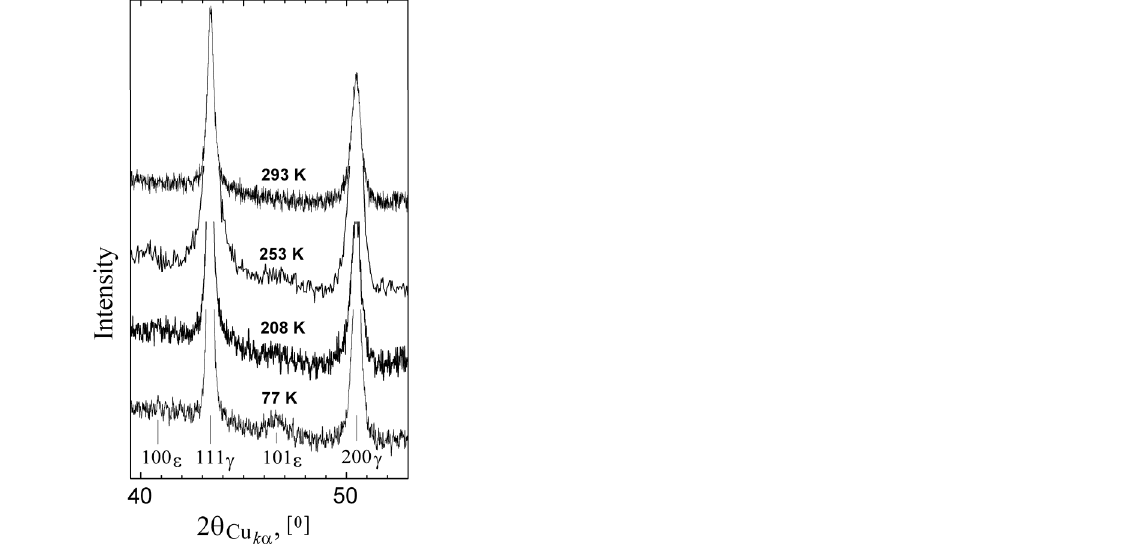
Figure 4. Fragments of the XRD diffraction patterns of the Cr-Mn-N steel after the tensile tests at various temperatures.